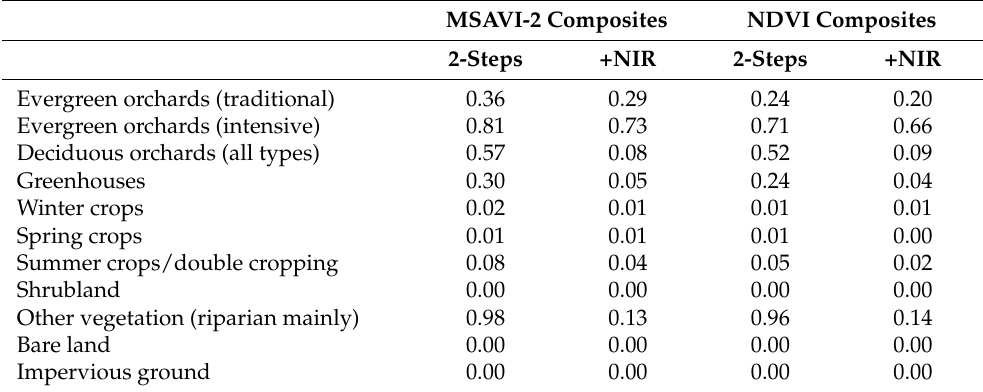
Table 6. Commission errors when using MSAVI-2 and NDVI composites, with and without the third (NIR) cluster and masking step.